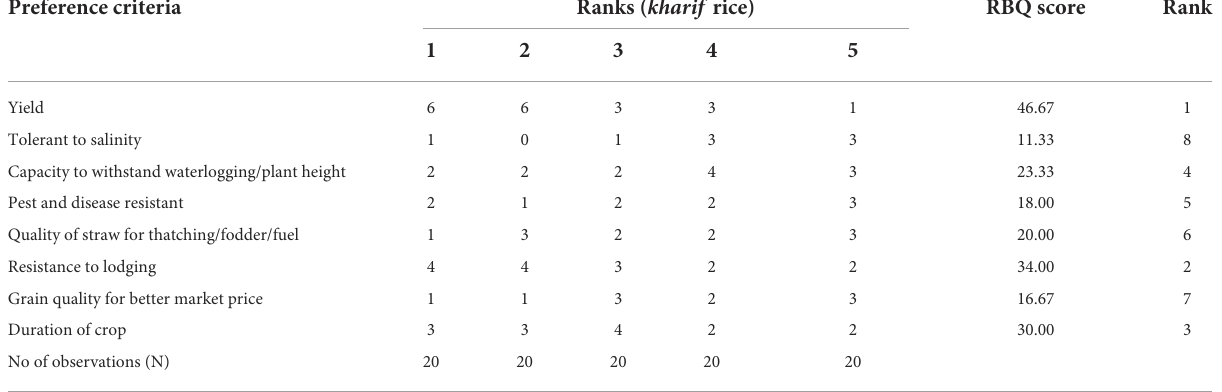
TABLE 2 Ranking of farmers criteria for preferring rice varieties. Preference